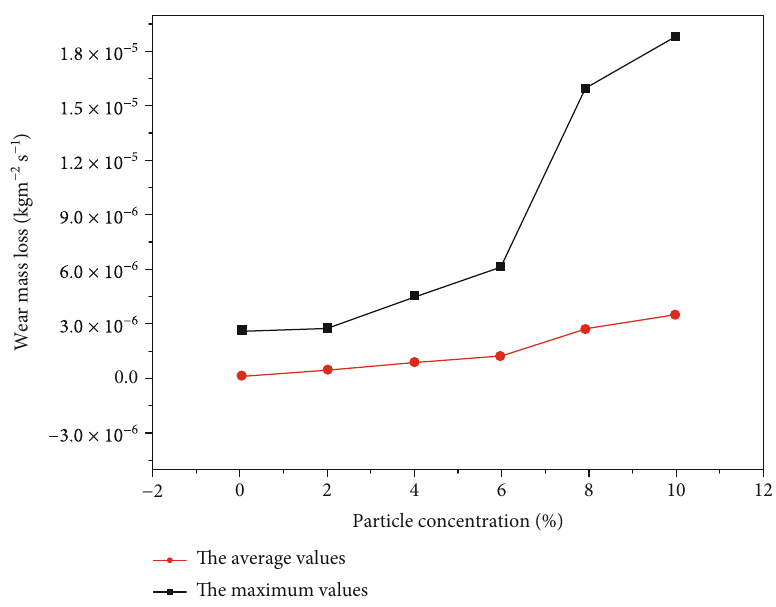
Figure 12: Variation of wear mass loss of volute material with particle concentration.